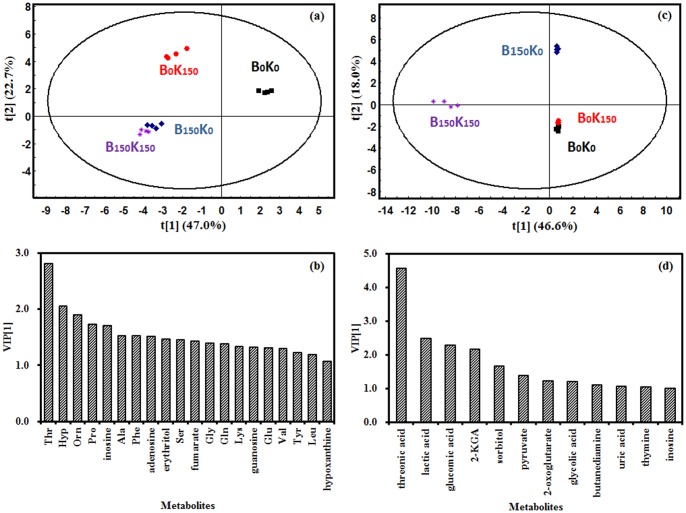
PLS-DA plots of intracellular samples in co-cultured B. cereus and K. vulgare.(a) score plot of t[1]/t[2] of samples at 48 h; (b) VIP plot generated from the metabolic data of 48 h; (c) score plot of t[1]/t[2] of samples at 96 h. (d) VIP plot generated from the metabolic data of 96 h. The explained variance was in brackets. The ellipse defines the Hotelling's T2 confidence region (95%). The VIP[1] values represent the contributing weights of each metabolite to 1st principal component of the PLS-DA model.